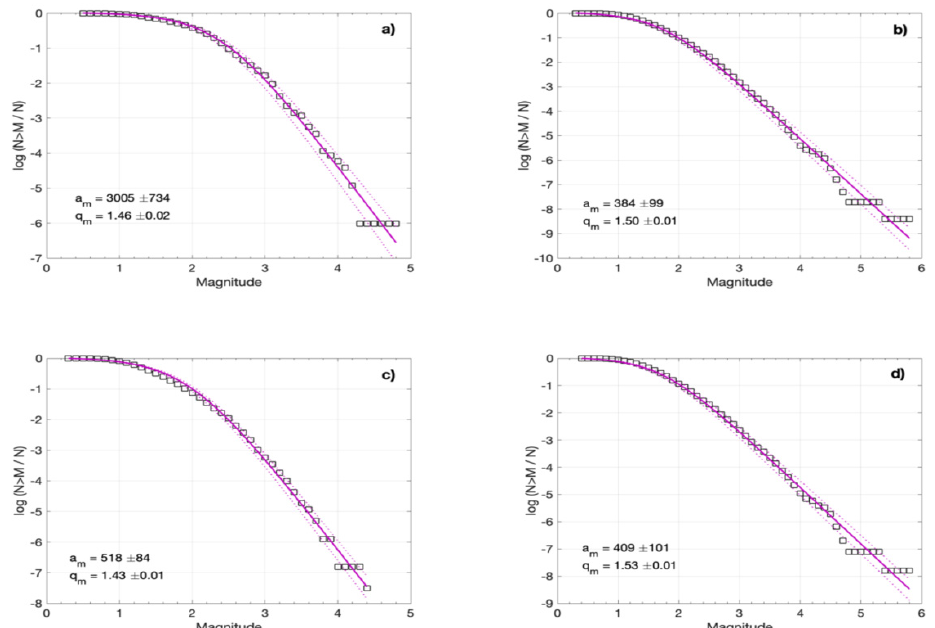
Figure 15. The frequency-magnitude distribution of earthquakes (squares) for the ( a ) foreshock sequence, ( b ) aftershock sequence, ( c ) NE aftershocks cluster, ( d ) SW aftershocks cluster. The corresponding fit according to Equation (6) is shown with the solid line, for the parameter values shown in the down left corner and Table 6. The dotted lines represent the 95% confidence intervals.